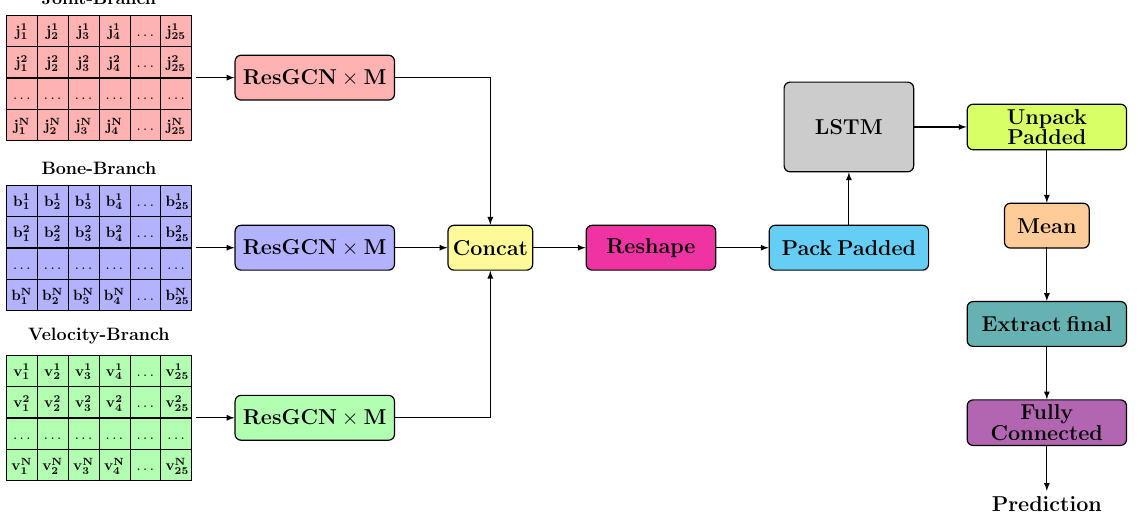
Figure 9. The proposed architecture for RNN-based